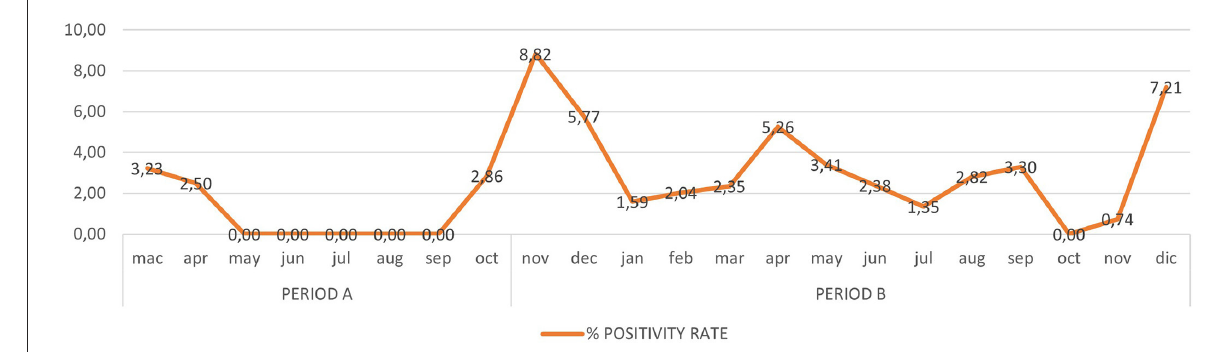
FIGURE4 The positivity rate of all molecular swabs (RT-PCR) from Mach 1, 2020 to December 31,